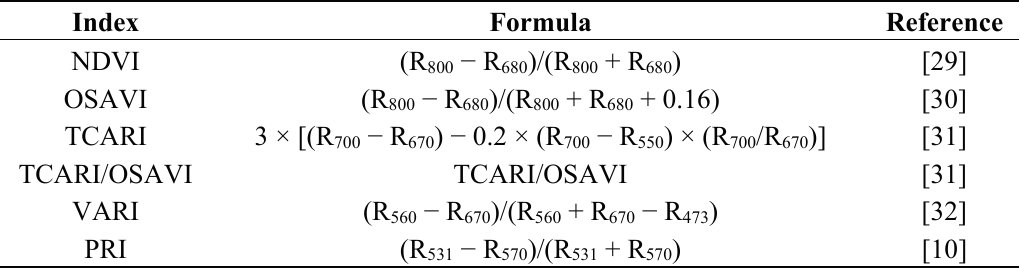
Table 3. Vegetation indices tested in this study. R x is the reflectance at the wavelength x of the CASI band centers used for calculations expressed in